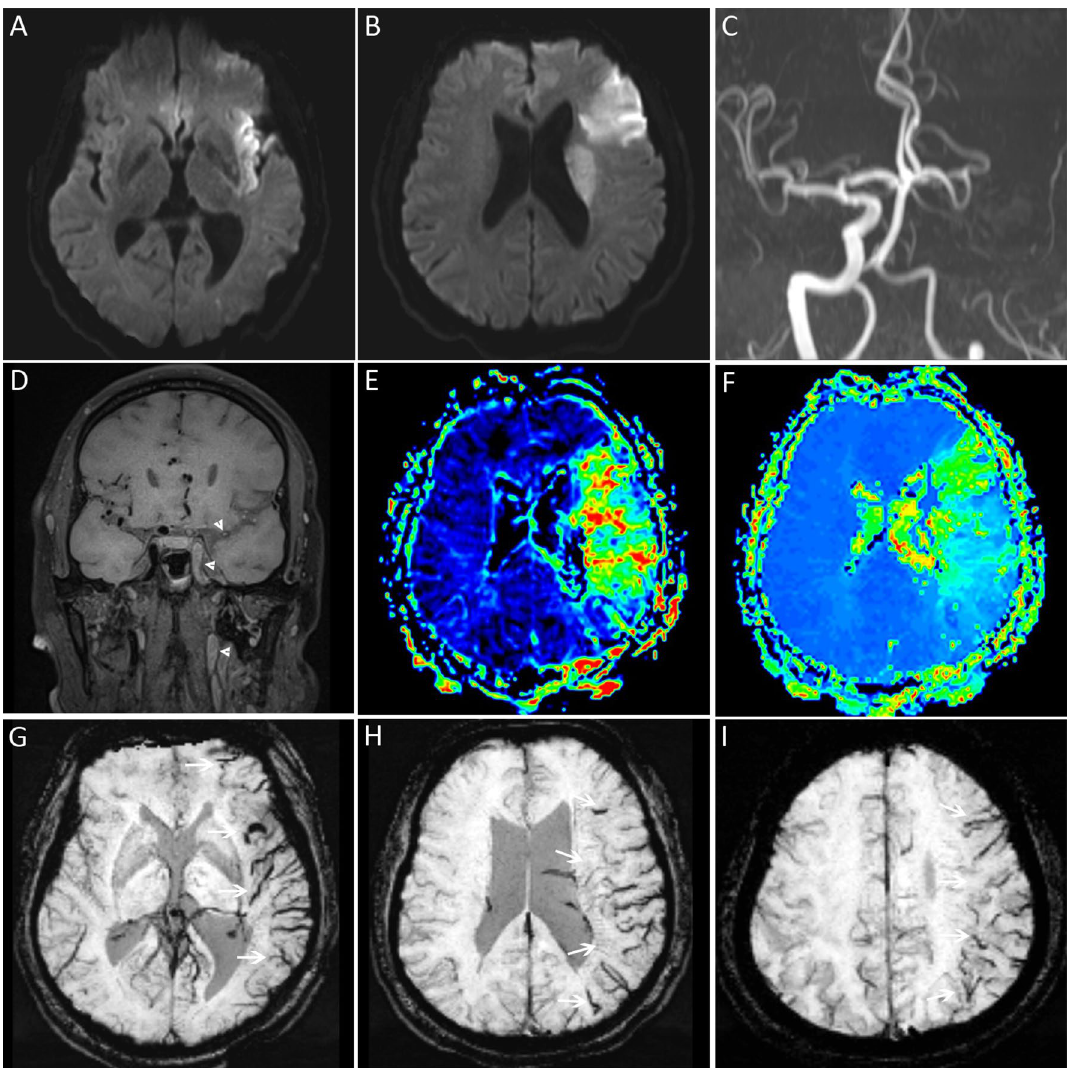
Figure 1. Prominent vessel sign was visible in a patient with anterior circulation stroke due to large vessel occlusion. DWI ( A , B ) revealed restricted diffusion in the left insular, frontal, and paraventricular areas. MRA ( C ) and 3D-SPACE ( D ) showed occlusion of the left internal carotid and middle cerebral arteries (white arrowheads). The MTT ( E ) and TTP ( F ) maps indicated hypoperfusion in the left middle cerebral artery territory. Asymmetric prominent hypointense vessels (white arrows), known as prominent vessel sign, appeared on SWI ( G – I ) in the affected